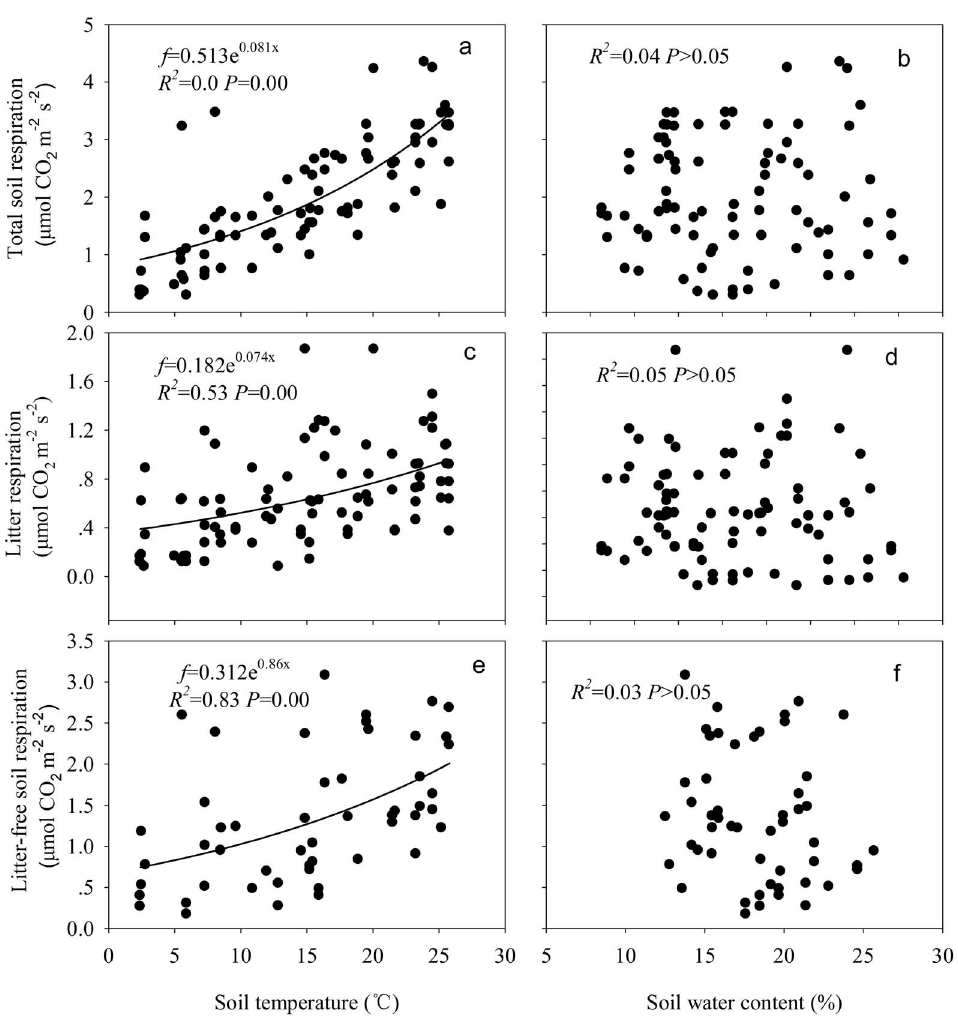
Figure 5. Relationships between the total soil respiration (a, b), litter respiration (c, d), litter-free soil respiration (e, f) and soil temperature at 5 cm depth or soil water content at 5 cm depth in different-aged Pinusmassoniana forests during the 18-months field observations.